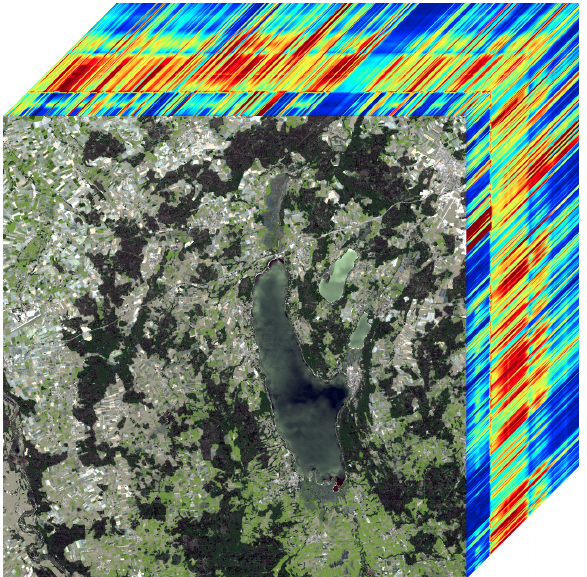
Figure 1. Near natural color visualization of the 244 channel sim- ulated EnMAP dataset Alpine Foreland, showing the area around the Ammersee in Bavaria, Germany. Dataset produced by Guan- ter et al. (2009), courtesy of Dr. K. Segl. Larger image available at: www.ipf.kit.edu/code.php